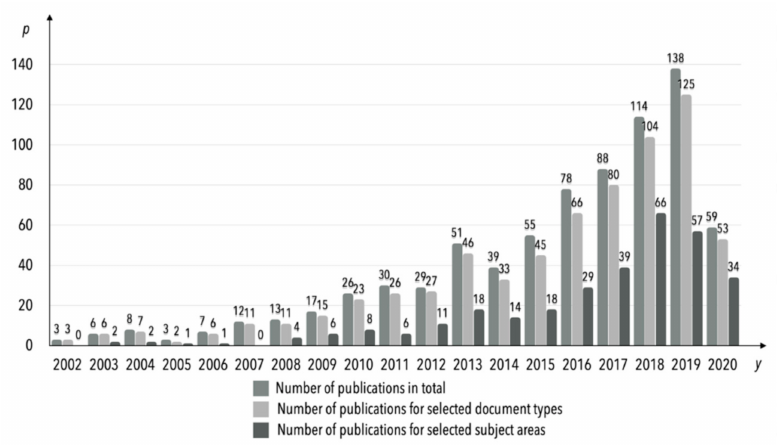
Figure 3. Number of publications ( p ) per year ( y ) in sustainable business models research between 2002 and 2020 in total, for selected document types, for selected subject areas. Source: own elaboration based on data from Scopus